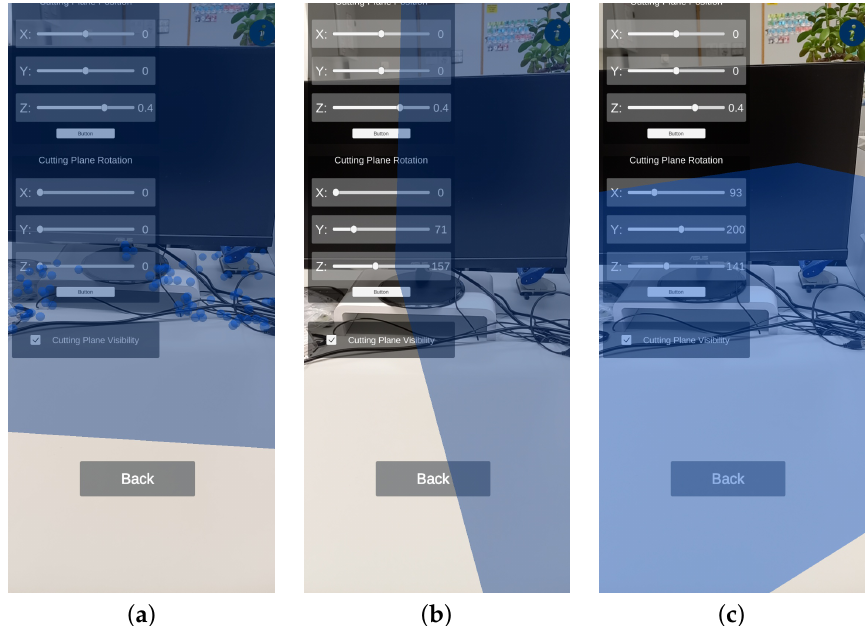
Figure 14. Implementation of the CuttingPlane UI by Abdullah Aldandarawy from the Cross Section Shader add-on from the Unity Asset Store. ( a ) CuttingPlane frontal orientation. ( b ) CuttingPlane rotated sideways. ( c ) CuttingPlane rotated over all